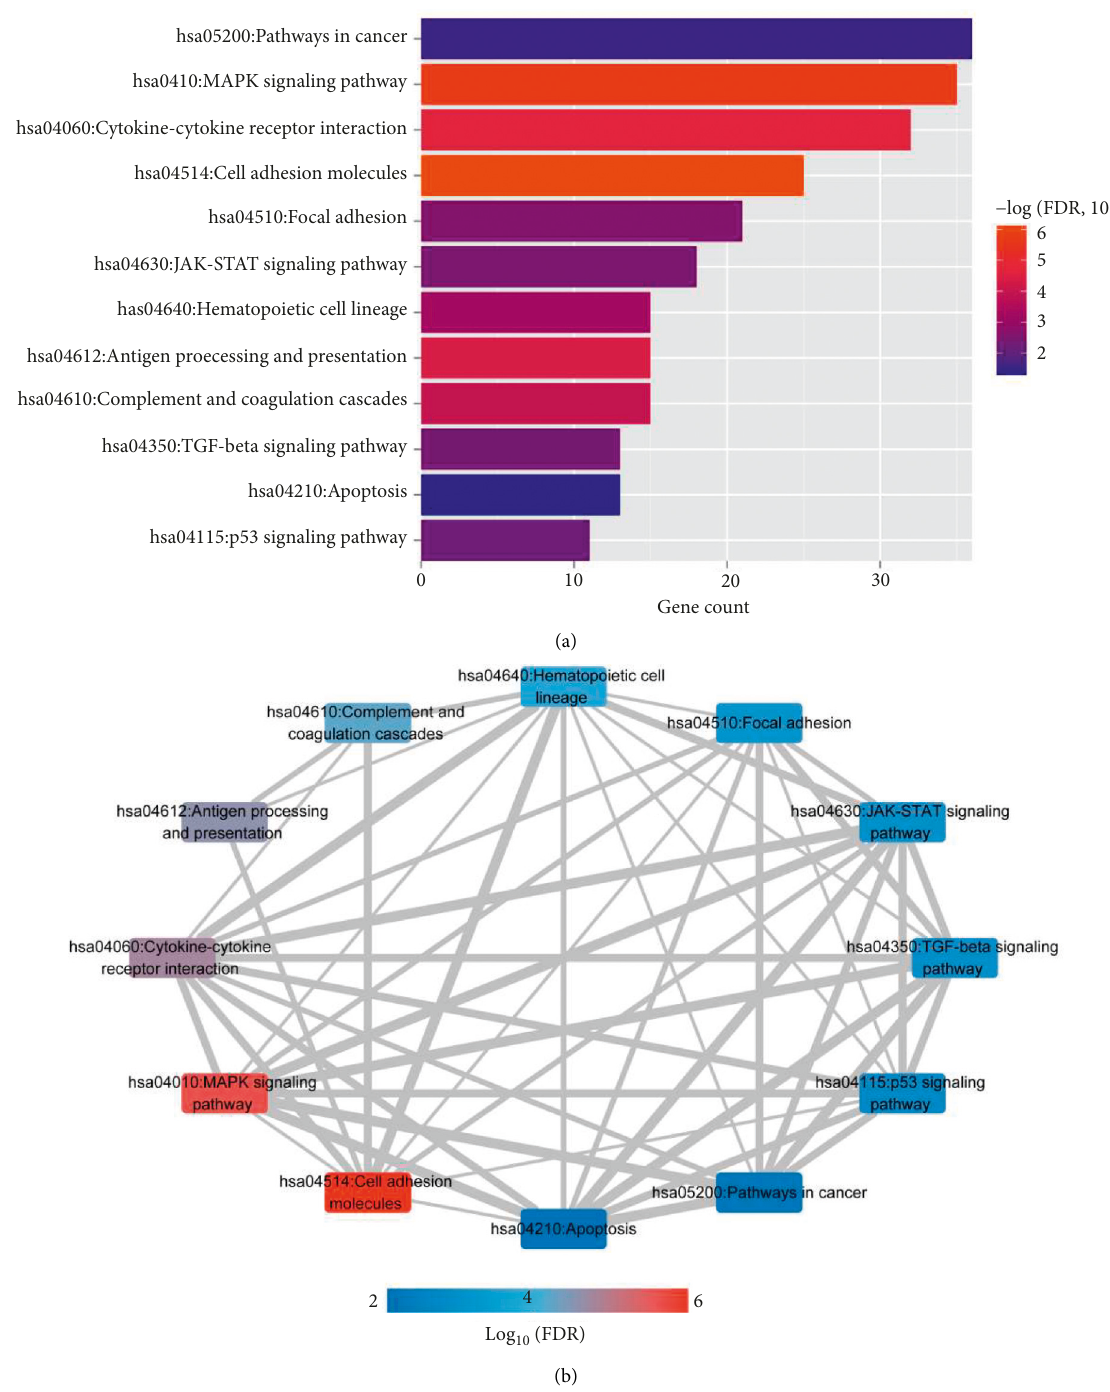
Figure 6: Through KEGG signal pathway enrichment analysis of 686 genes significantly enriched in 6 modules, a total of 12 significantly related frontal KEGG signal pathways were obtained, as shown in Figure 6(a). Then, the quantitative analysis of 12 KEGG signal pathways with significant enrichment correlation was carried out, and 50 pairs of interconnected pairs were obtained after retaining the connection pairs with P value less than 0.05 and absolute value of correlation p value higher than 0.5, so as to construct the cross talk network of KEGG signal pathway, as shown in Figure